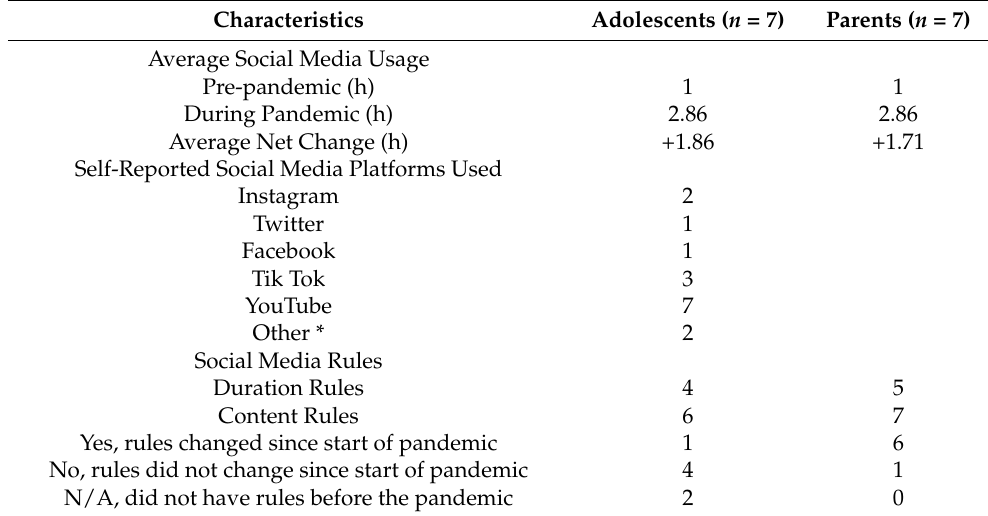
Table 4. Adolescent Social Media Usage Characteristics Reported by the Adolescents and Their